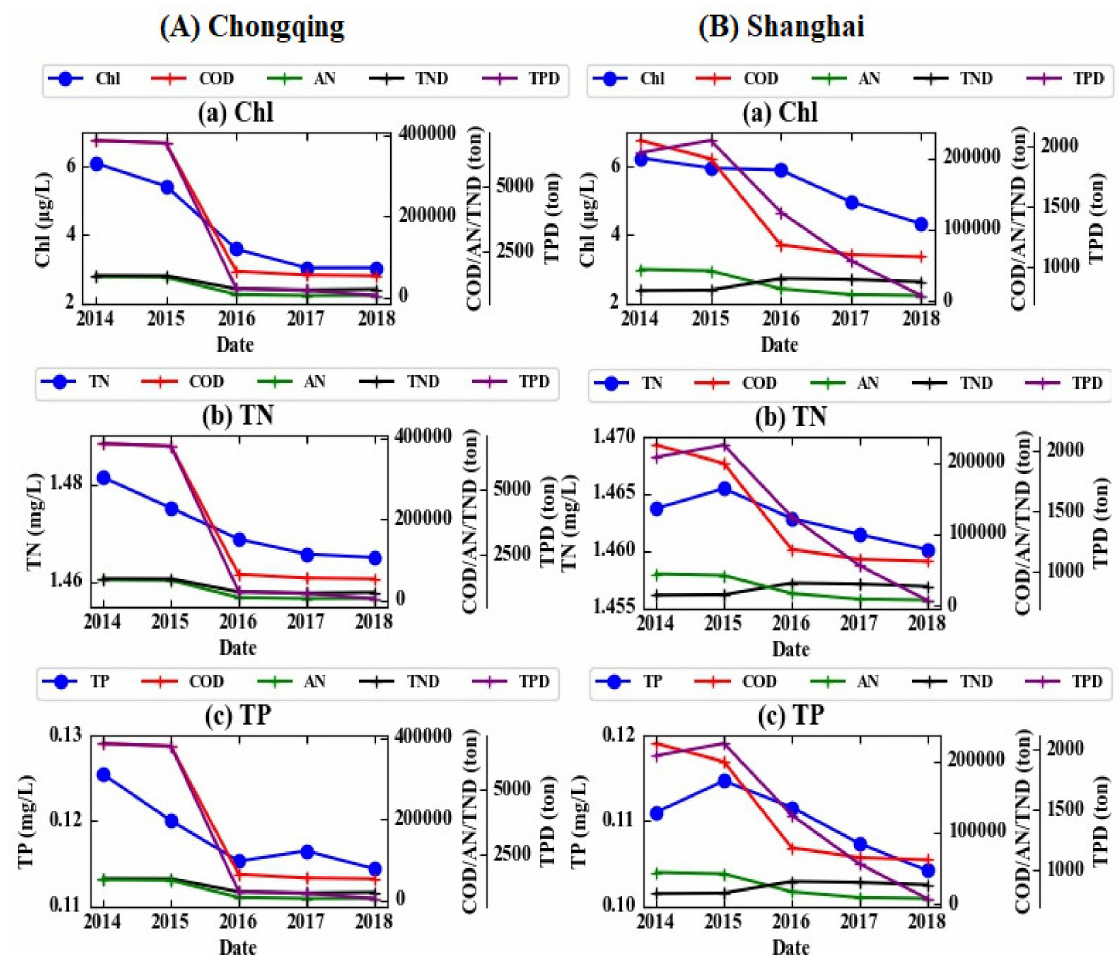
Figure 11. Variations in emissions of four pollutants and variations in ( a ) Chl-a, ( b ) TN, and ( c ) TP concentrations in Chongqing and Shanghai from 2014 to 2018.